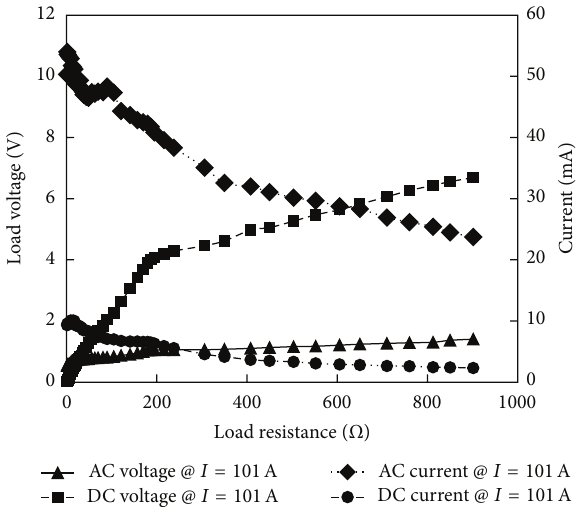
Figure 25: Super capacitor’s and battery’s voltage with respect to charging